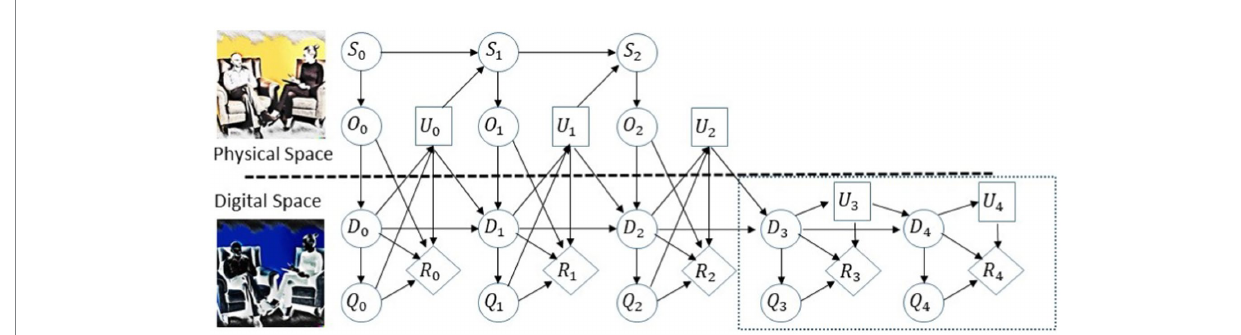
FIGURE 1 Probabilistic graphic model for the ADT, adapted from Kapteyn et al. (17). The upper path of the graphical model represents the time evolution of the physical asset states, denoted by S; the lower path represents the time evolution of the digital states, denoted by D. The graphical model encodes the coupling over time between an asset and its DT. At each time point, we measure the physical asset and this information flows into the DT denoted by O. The observational data are used to update the digital states D and the models comprising the DT, which, in turn, are used to predict quantities of interest Q. Then, based on model predictions a decision or control input U is chosen and applied to the physical asset. The above quantities and actions influence the reward denoted by